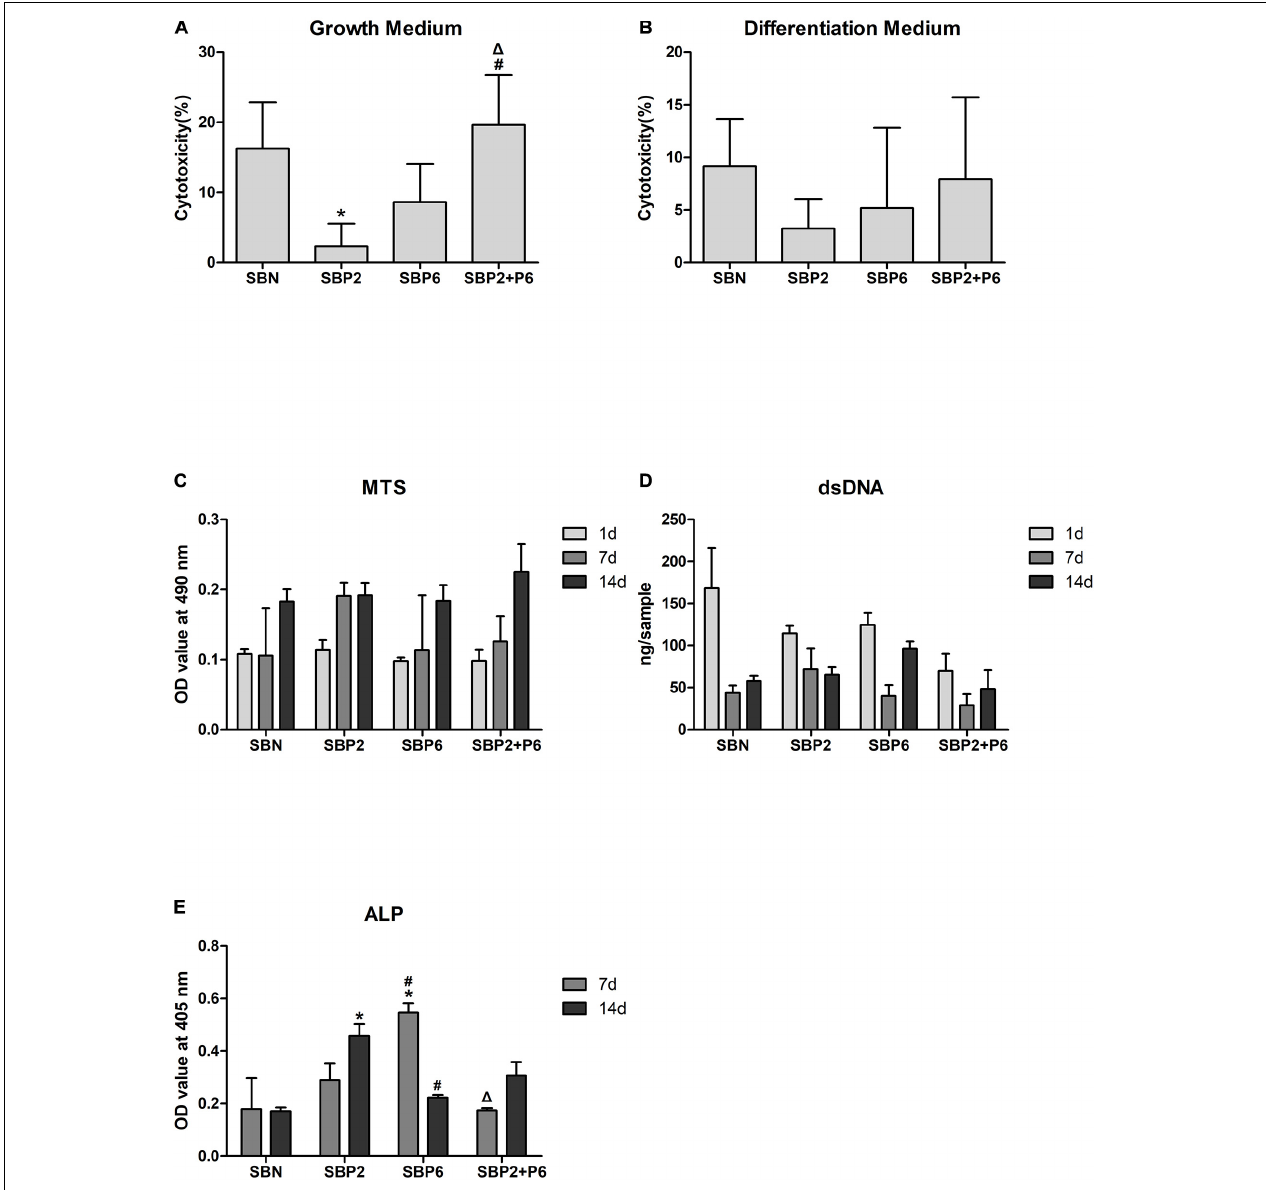
FIGURE 2 | (A,B) Cytotoxicity of SBN and SBP analyzed via lactate dehydrogenase (LDH) activity. (C) Metabolic activity of hMSCs. (D) dsDNA quantification. (E) alkaline phosphatase (ALP) activity. * p < 0.05 for when compared to SBN, # p < 0.05 for when compared to SBP2, (cid:49) p < 0.05 for when compared to SBP6 ( n =